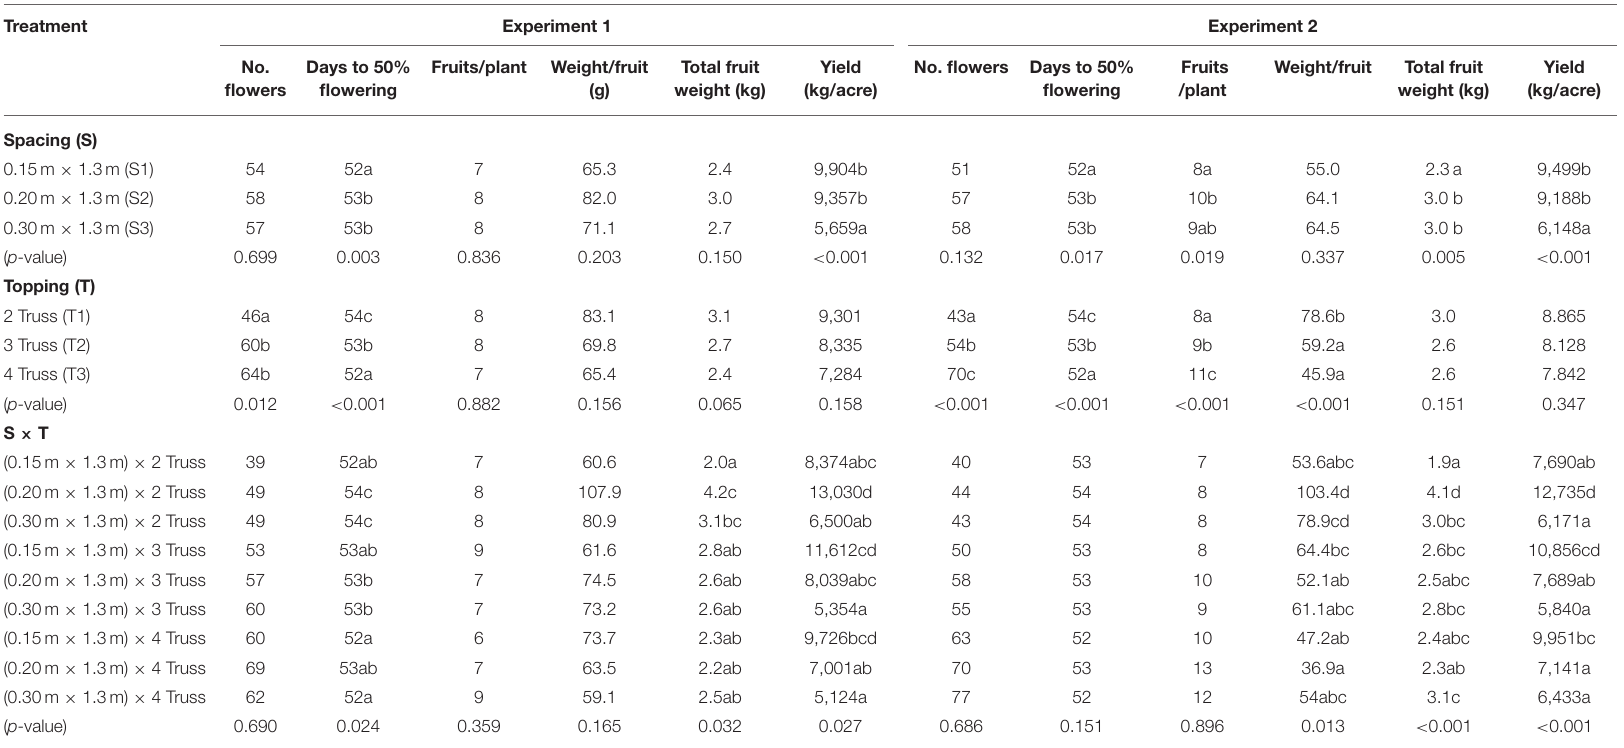
TABLE 9 | Effect of spacing and topping on yield and yield components of Solanum lycopersicum under greenhouse